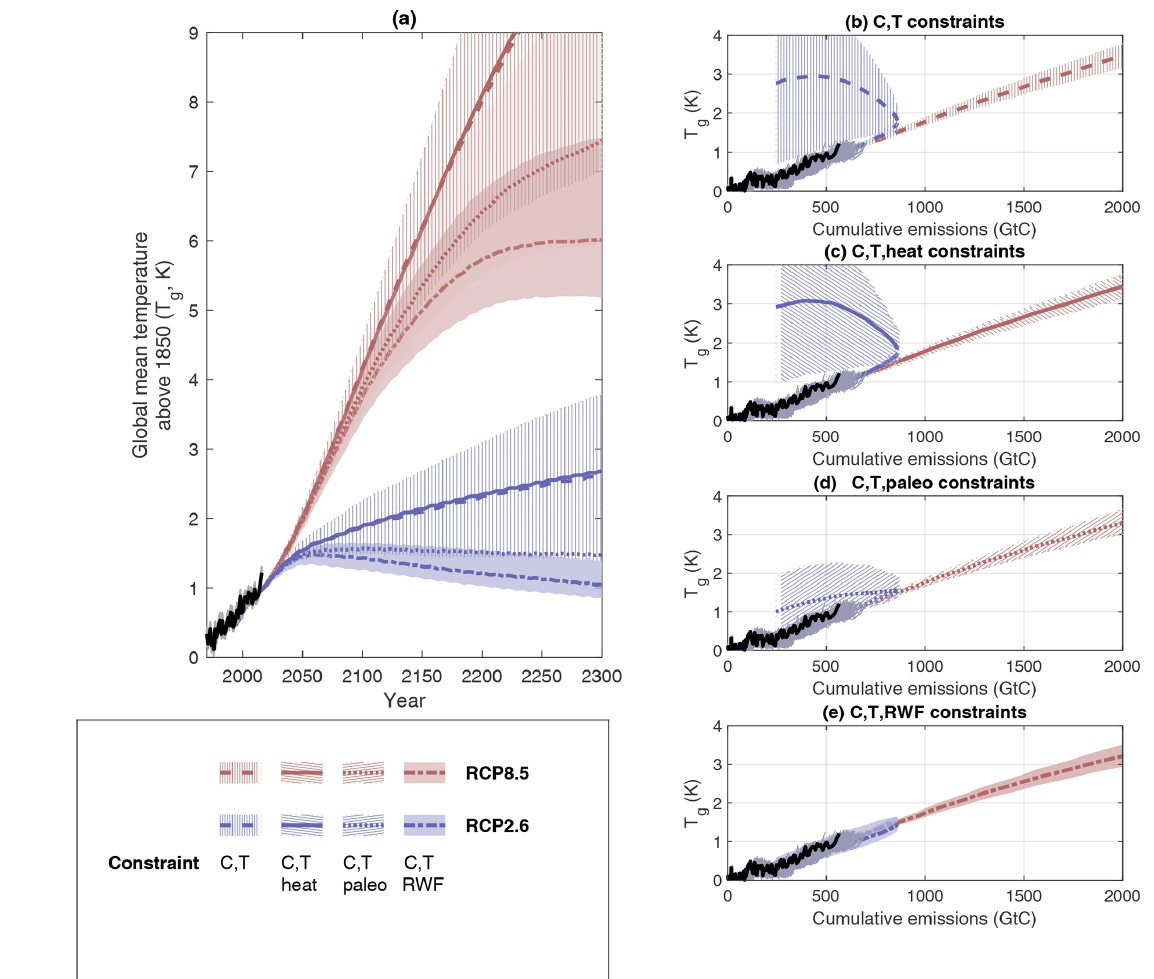
Figure 1. Posterior distributions of future global mean temperature projections constrained by 1850–2016 historical temperatures in a range of scenarios, priors and structural choices as a function of (a) time and (b–e) cumulative emissions of carbon (with 1000 years of climate evolution plotted from 1851 to 2850). Colored lines represent RCP8.5 (red) and RCP2.6 (blue). Panel (b) and dashed lines in (a) show two-timescale model posterior constrained using emissions ( C ) and temperature ( T ) only; (c) and solid lines in (a) are constrained using C , T and ocean heat content ( H ); (d) and dot–dash lines in (a) use C , T and RWF. Panel (e) and dotted lines use constraints on C , T and a paleoclimate prior on ECS. Shaded regions indicate the 10–90th percentile range. Solid black lines show observed global mean temperature median estimate (Cowtan and Way, 2013) and most likely estimates of combined land use and fossil fuel emissions (Le Quéré et al., 2018). Grey lines show uncertainties in observed temperature–cumulative-emissions following Millar and Friedlingstein